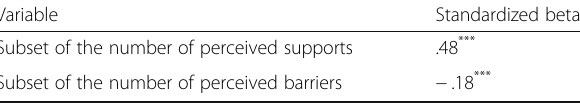
Table 6 Multiple regression results Variable Standardized beta